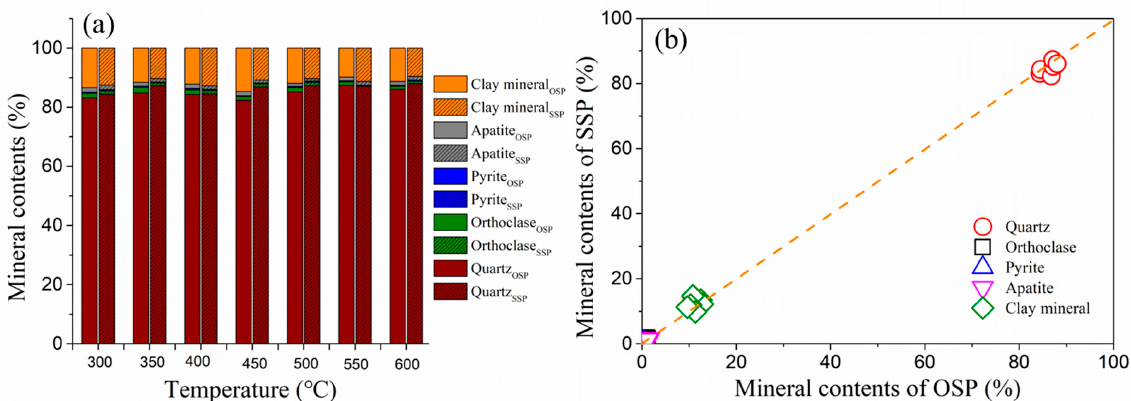
Figure 4. ( a ) Columnar diagram of mineral contents between two pyrolysis experiments, and ( b ) Mineral contents comparison between two pyrolysis experiments. Notes: OSP-Open system pyrolysis; SSP- Semi-closed system pyrolysis. Data of semi-closed pyrolysis are cited by Fang et al. [21].